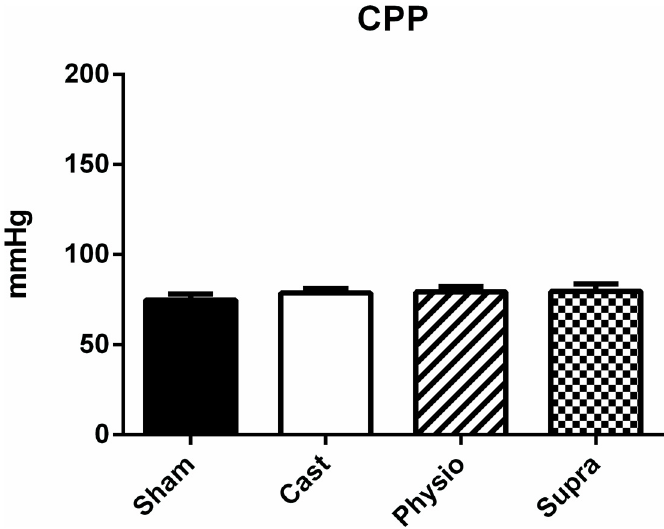
Fig 2. Baseline coronary perfusion pressure (CPP) of normotensive rats. SHAM (n = 20), CAST (n = 23), PHYSIO (n = 20), and SUPRA (n = 23) groups. The values are expressed as the mean ± SEM.